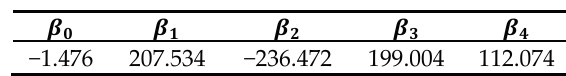
Table 2. Regression Coefficient for Model